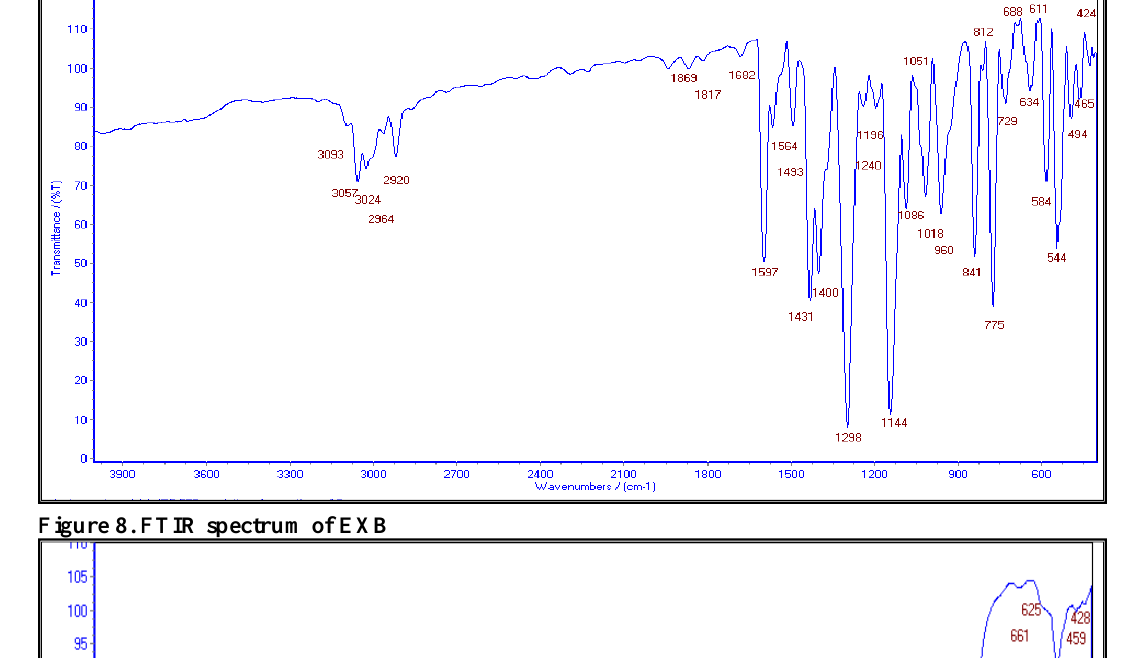
Figure 8. FTIR spectrum of EXB